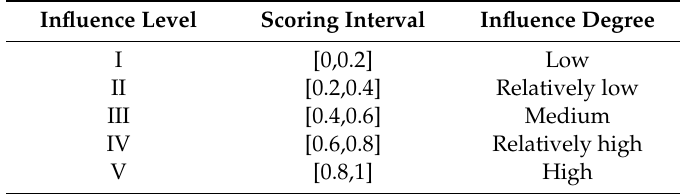
Table 2. The interval classification of the impact degree of the risk indicator.